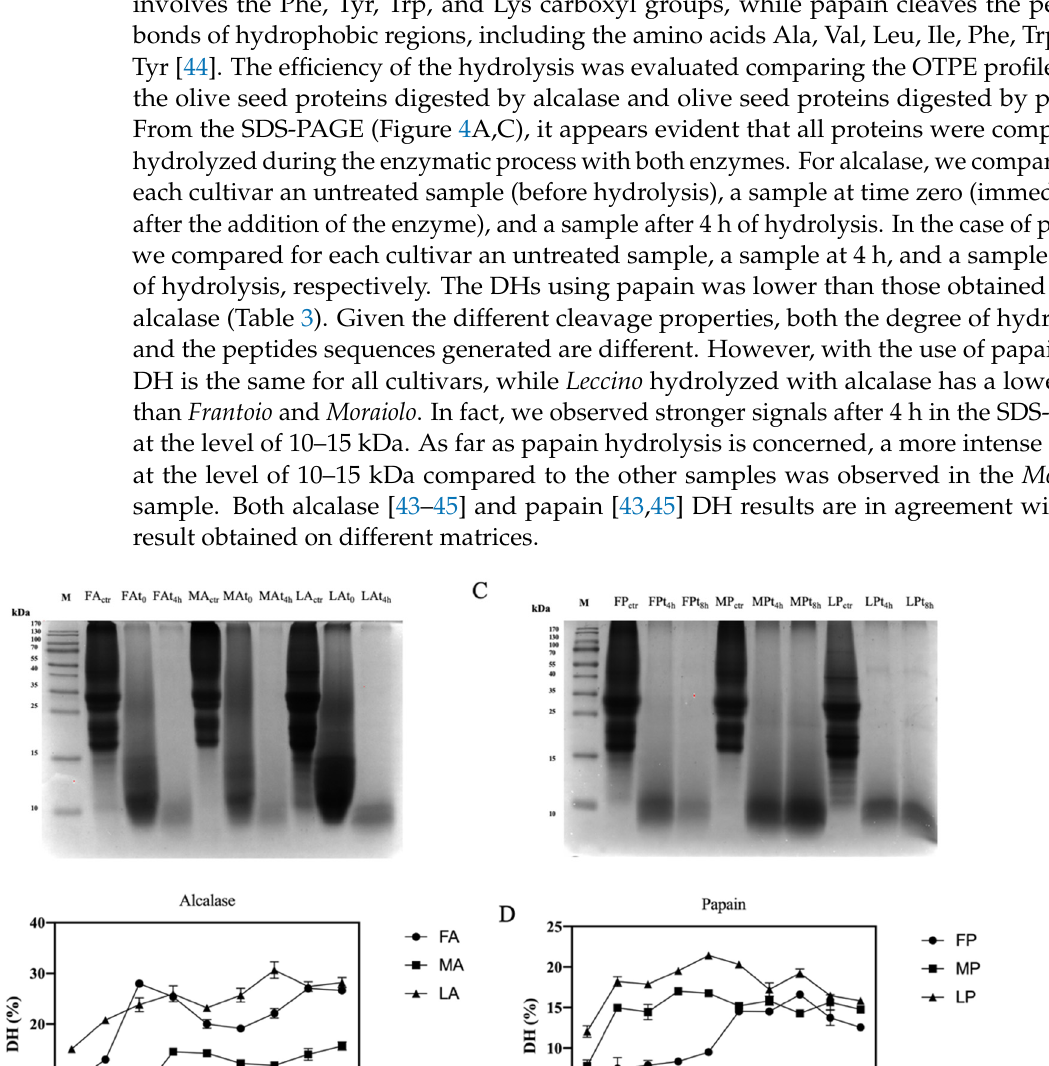
Figure 4. Digestion efficiency of olive seed total protein extract and degree of hydrolysis (DH) trend. ( A ) SDS-PAGE analysis of alcalase hydrolysates at different hydrolysis time points. FA, Frantoio digested by alcalase; MA, Moraiolo digested by alcalase; LA, Leccino digested by alcalase. ( B ) Alcalase DH at different time points. ( C ) SDS-PAGE analysis of papain hydrolysates at different hydrolysis time points. FP, Frantoio digested by papain; MP, Moraiolo digested by papain; LP, Leccino digested by papain. ( D ) Papain DH at different time points. The data are represented as the means ± s.d. of three independent experiments; each experiment was performed in triplicate.